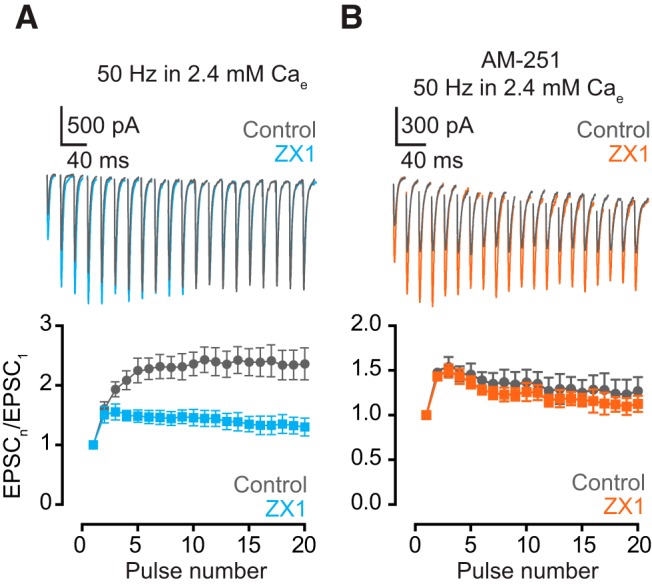
Enhanced zinc-mediated synaptic facilitation depends on endocannabinoid signaling. A, B, Upper panels, representative traces of AMPA EPSCs evoked by 50-Hz 20-pulse train before (gray) and after ZX1 application (color), in the absence (A) or presence (B) of AM-251. Lower panels, summary graphs showing average AMPA EPSC amplitudes during the train, normalized to EPSC amplitude elicited by first pulse, before (A and B, gray) and after (A and B, color) ZX1 application, in the absence (A), or presence (B) of AM-251 (ratio of the amplitude of 16–20 EPSC to first EPSC at 50 Hz: in the absence of AM-251: control vs. ZX1, n = 10, p < 0.01; in the presence of AM-251: control vs. ZX1, n = 5, p = 0.32). Values represent mean ± SEM. Detailed values and statistical tests: Lower panels: ratio of the amplitude of 16–20 EPSC to first EPSC at 50 Hz: in the absence of AM-251: control: 2.29 ± 0.25 vs. ZX1: 1.32 ± 0.15, n = 10, p < 0.01, F = 52.81, DFn = 1, DFd = 90; in the presence of AM-251: control: 1.19 ± 0.15 vs. ZX1: 1.04 ± 0.09, n = 5, p = 0.32, F = 1.0, DFn = 1, DFd = 40; two-way ANOVA.